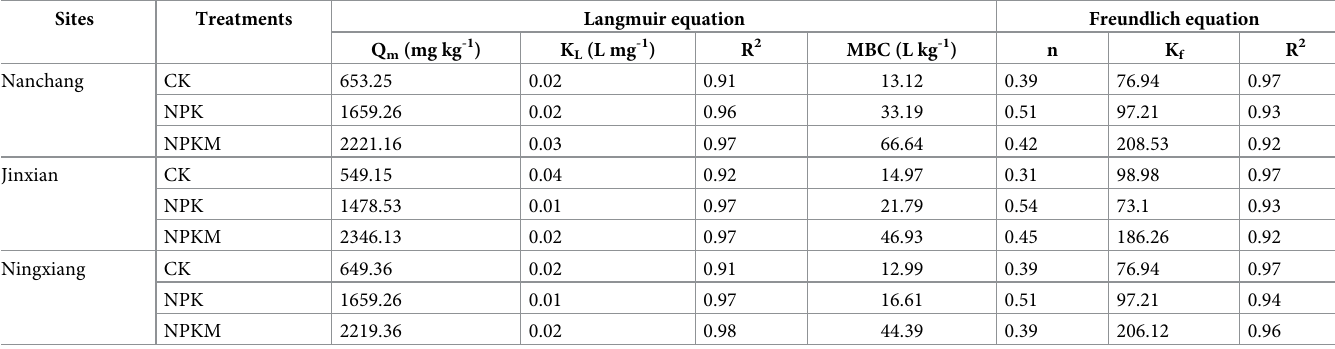
Table 4. Isotherm parameters of the Langmuir and Freundlich models for soil P adsorption. Sites